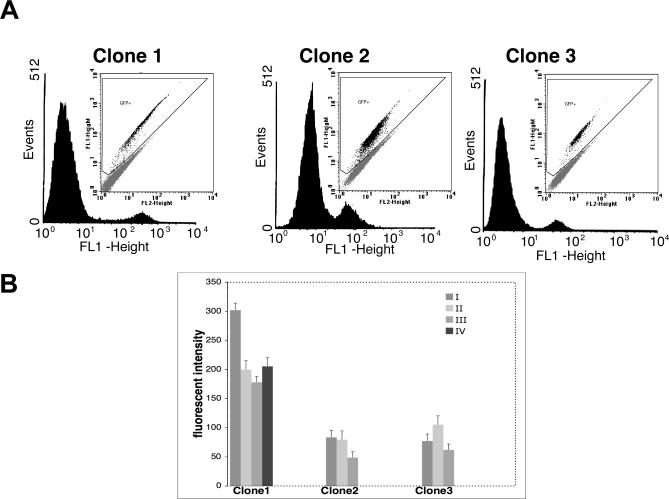
Recombination in Individual DR-GFP ClonesSingle clones were isolated from pooled cultures of Hela carrying inactive copies of DR-GFP. The three clones analyzed indicated as 1, 2, and 3 contained a single insertion with one or four copies of DR-GFP by Southern blot and qPCR (Figure S2). These clones were transfected in several independent experiments with I-SceI and pSVβGal vectors and scored for GFP+ cells.(A) Shown is FACS analysis of three clones 72 h after I-SceI transfection. The ordinate shows the number of cells and the abscissa the intensity of the fluorescence, respectively. The inset shows the dot plot of the bivariate analysis.(B) The experiment illustrated in (A) was repeated several times, and the mean of intensity of fluorescence of GFP+ cells is shown in the histogram. The roman numerals indicate an individual experiment.